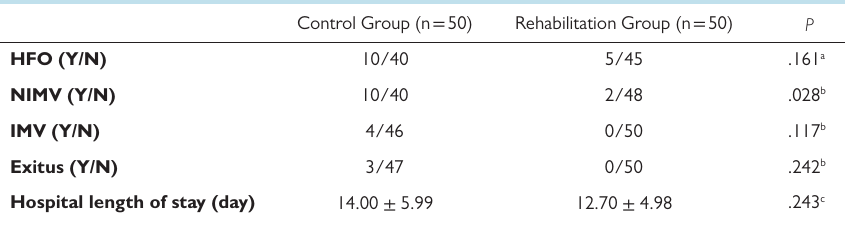
Table 6. Characteristic of Mechanical Ventilation and Status of